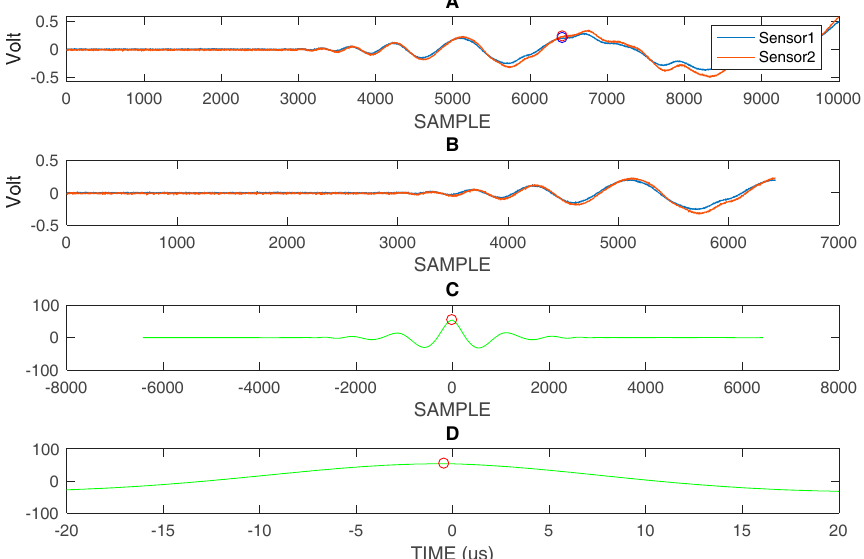
Figure 8. ( A ) impact #1: acquired signal sensor 1 and sensor 2 with marked positions by circles indicating the end of the time window that is used for further processing, ( B ) Selected time window, ( C ) correlation evaluated with the two selected signals shown in ( B ), ( D ) zooming of correlation in ( C ) and representation on time scale: differential time of arrival (DToA) = − 0.44 µs. Ts = 40 ns.